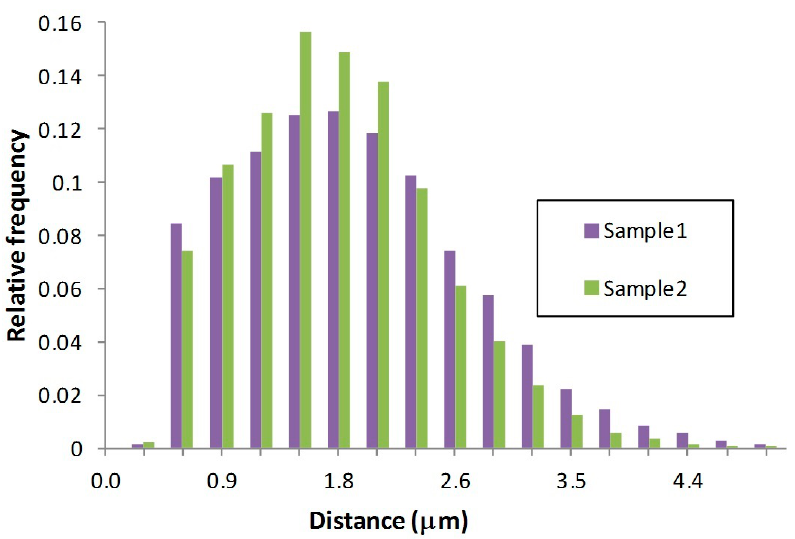
Figure 9. Carbide distribution for Samples 1 and 2.